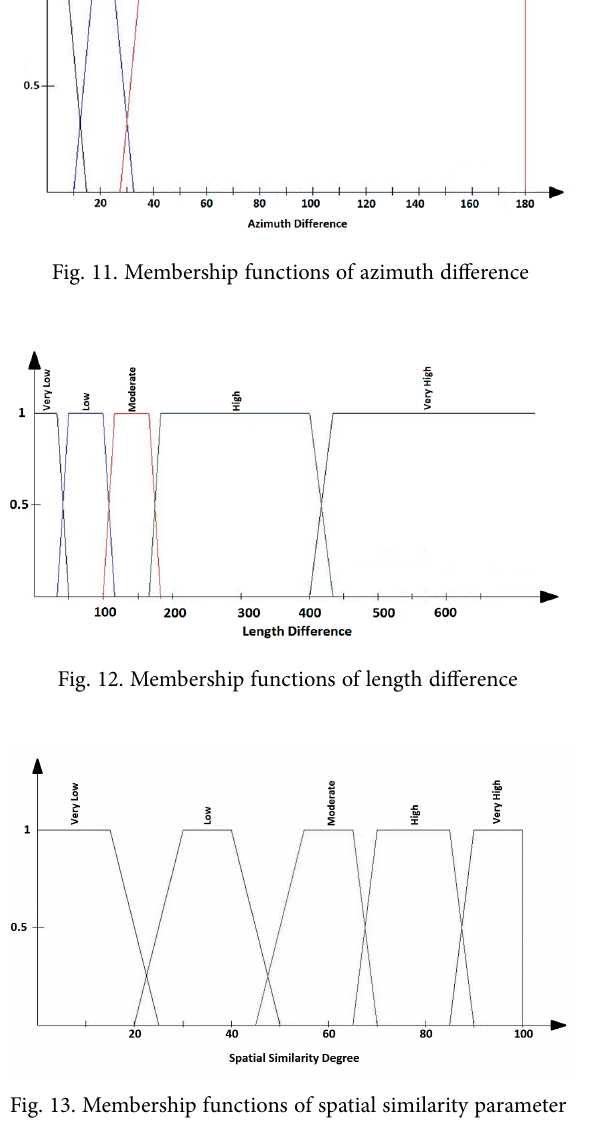
Fig. 13. Membership functions of spatial similarity